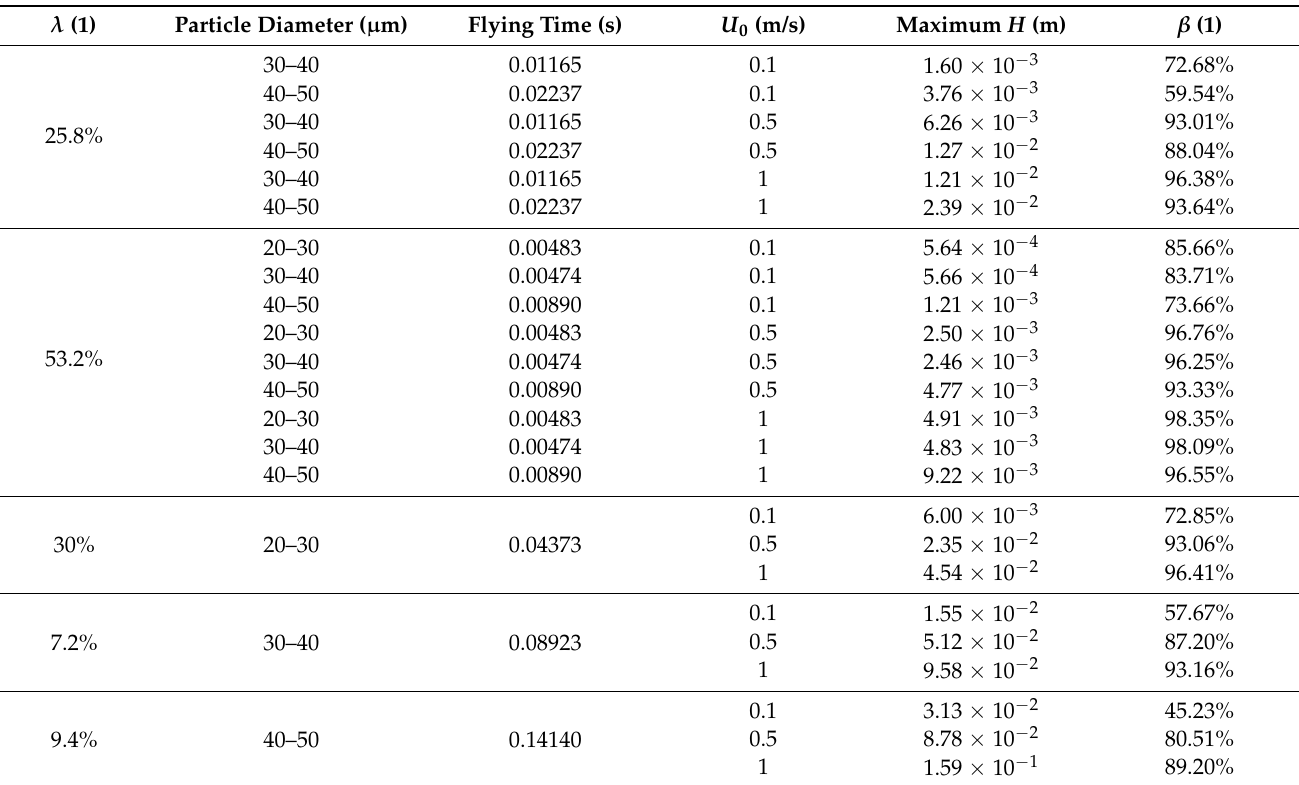
Table 4. Maximum H of particles before reaching the optics surface at different λ (below maximum attenuation